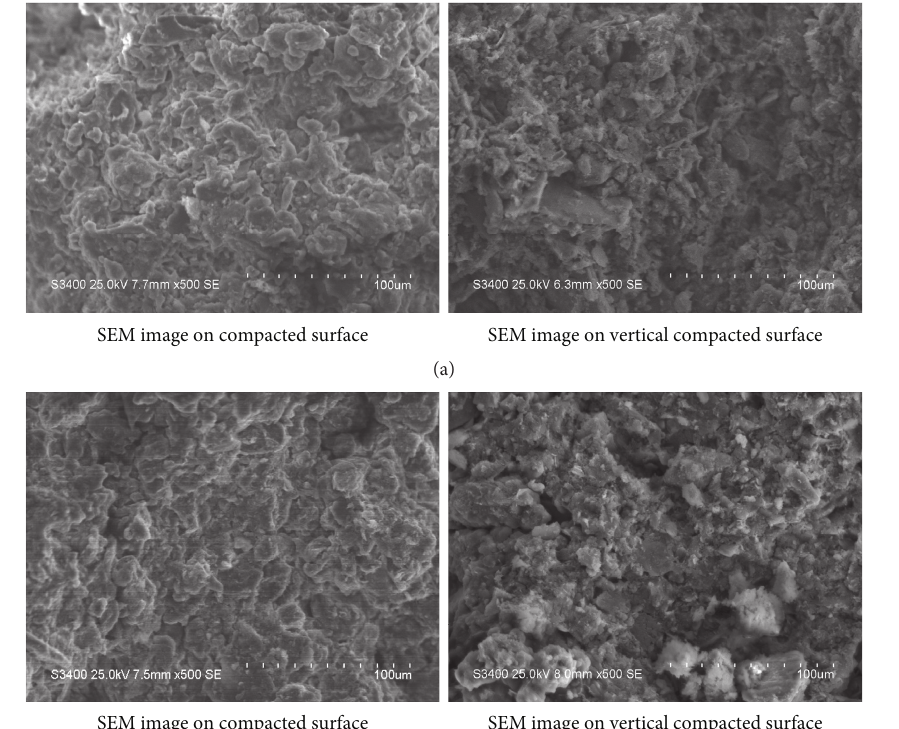
0 consolidation and confining pressure